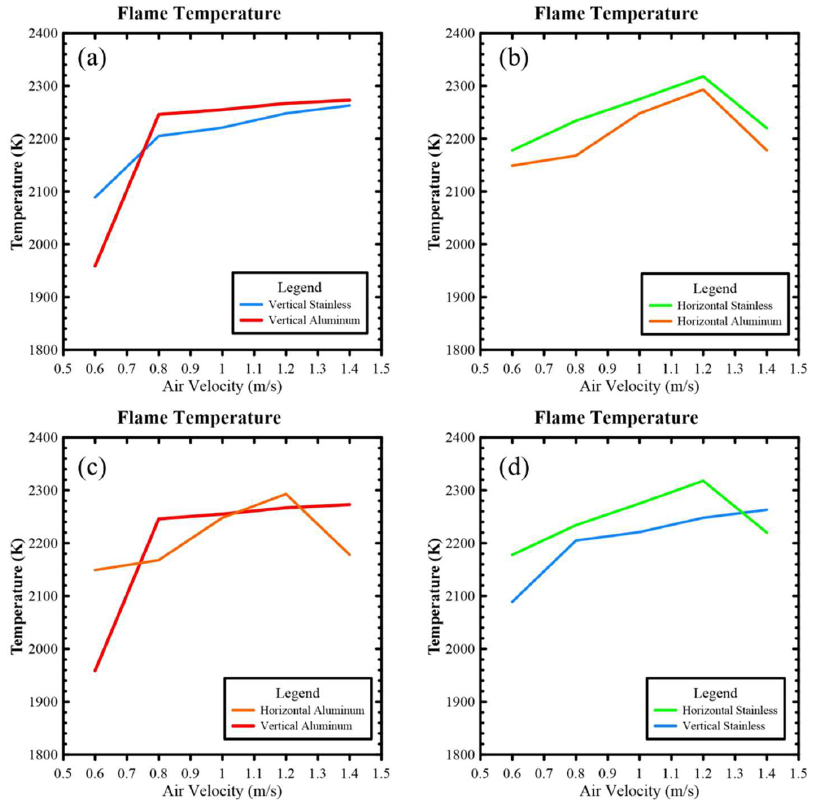
Figure 13. Flame temperatures from numerical simulations for ( a ) vertical vortex combustor, ( b ) horizontal vortex combustor, ( c ) vortex combustor with aluminum material, and ( d ) vortex combustor with stainless material .